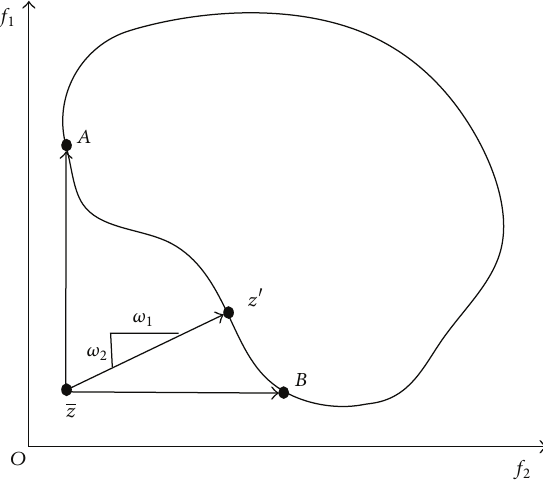
Figure 2: Illustration of weighted metric function